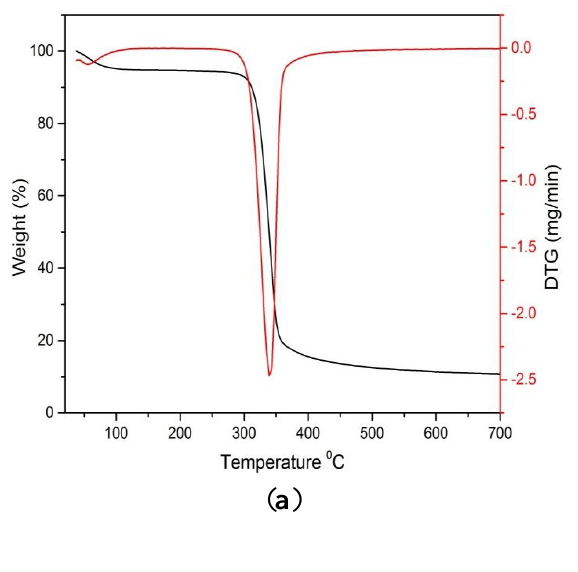
Figure 7. Thermogravimetric analysis of: ( a ) untreated MCC; ( b ) hydrolyzed MCC; and relation between weight loss % and time of ( c ) untreated MCC; ( d ) treated MCC in the presence of FeCl 3